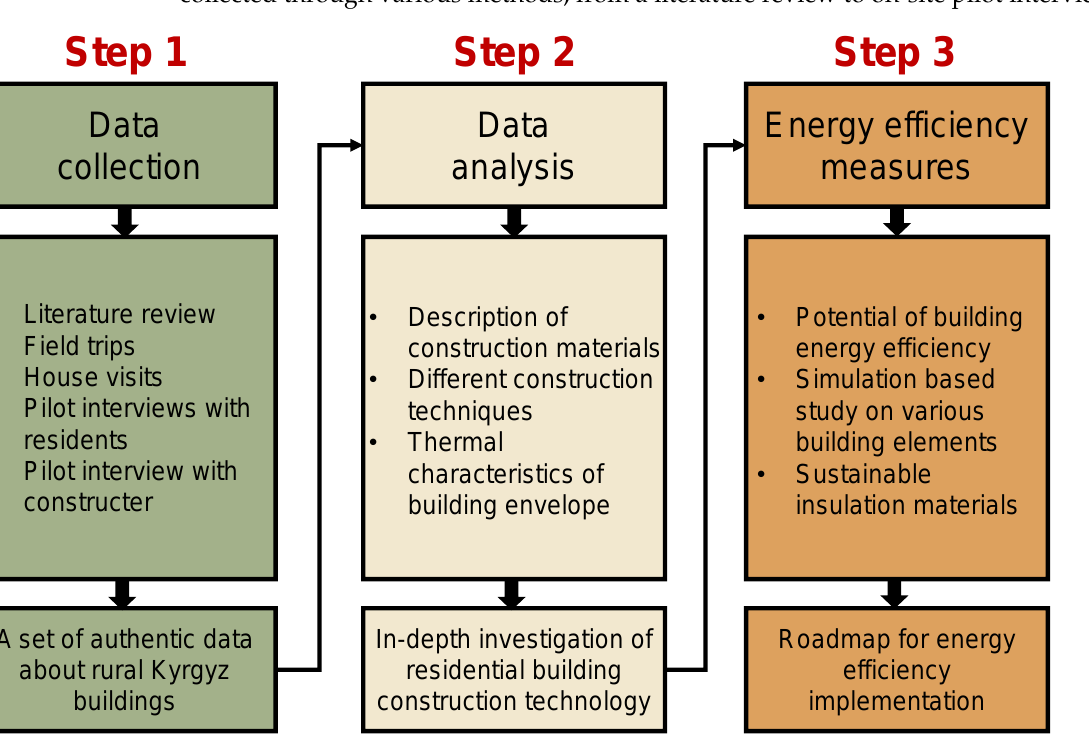
Figure 4. Research methodology of the presented article.